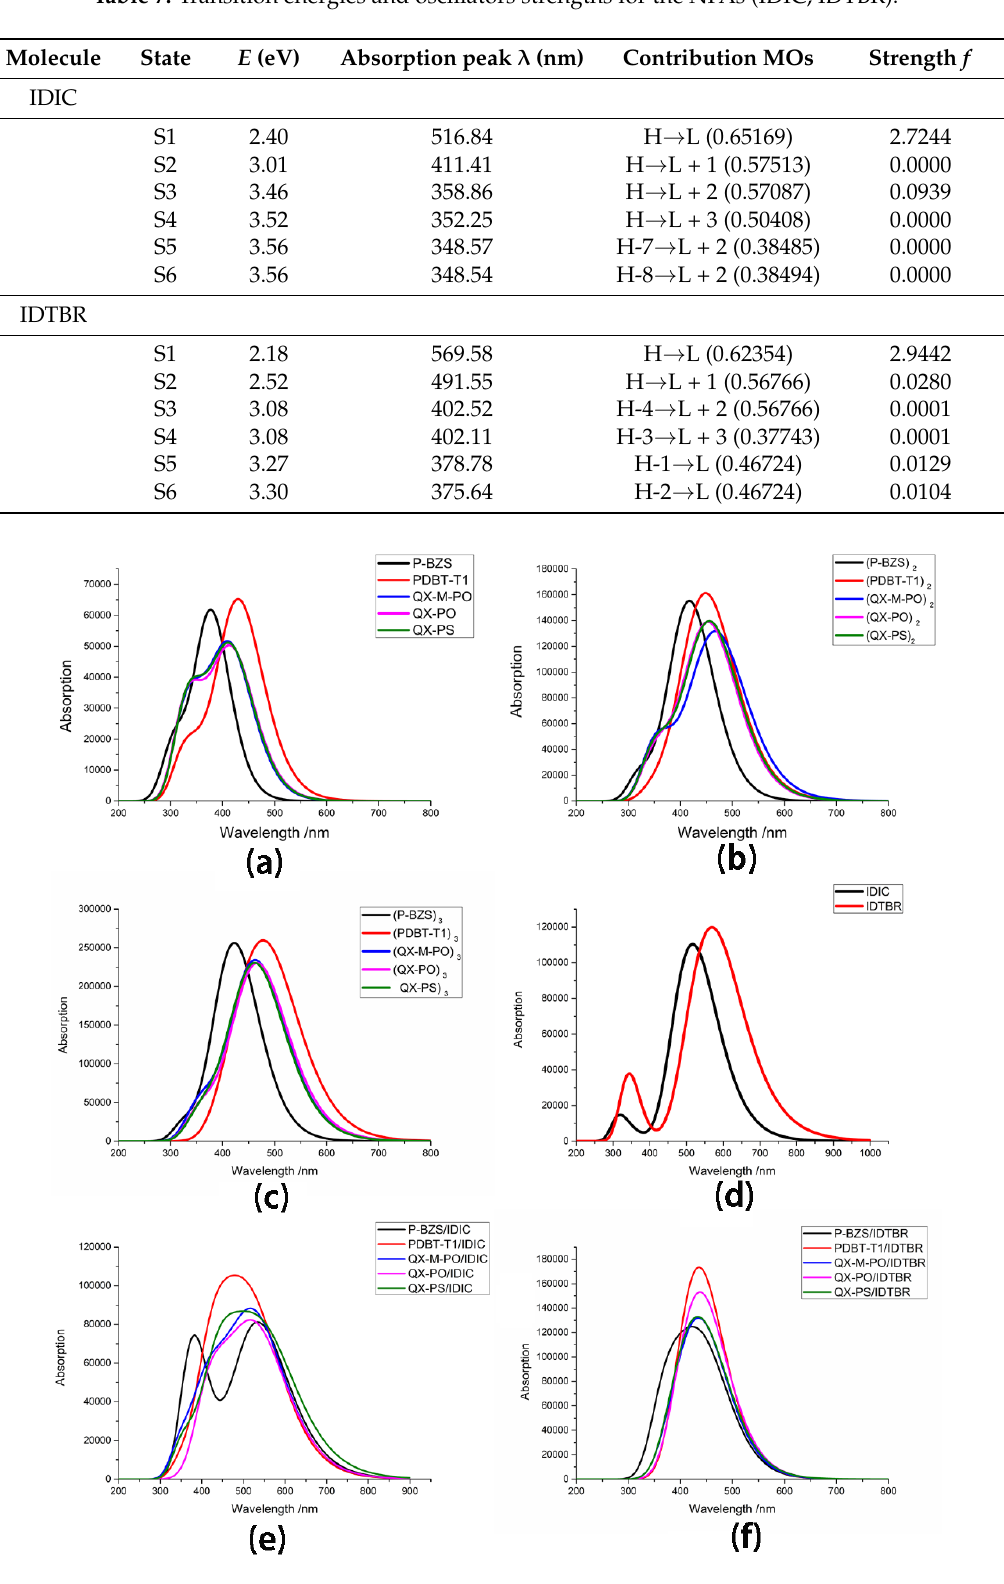
Figure 7. Absorption spectra of all the oligomers for: ( a ) n = 1; ( b ) n = 2; and ( c ) n = 3; ( d ) absorption spectra of NFAs IDIC and IDTBR; ( e ) absorption spectra of D/A interfaces polymer/IDTBR; and ( f ) absorption spectra of D/A interfaces polymer/IDIC.